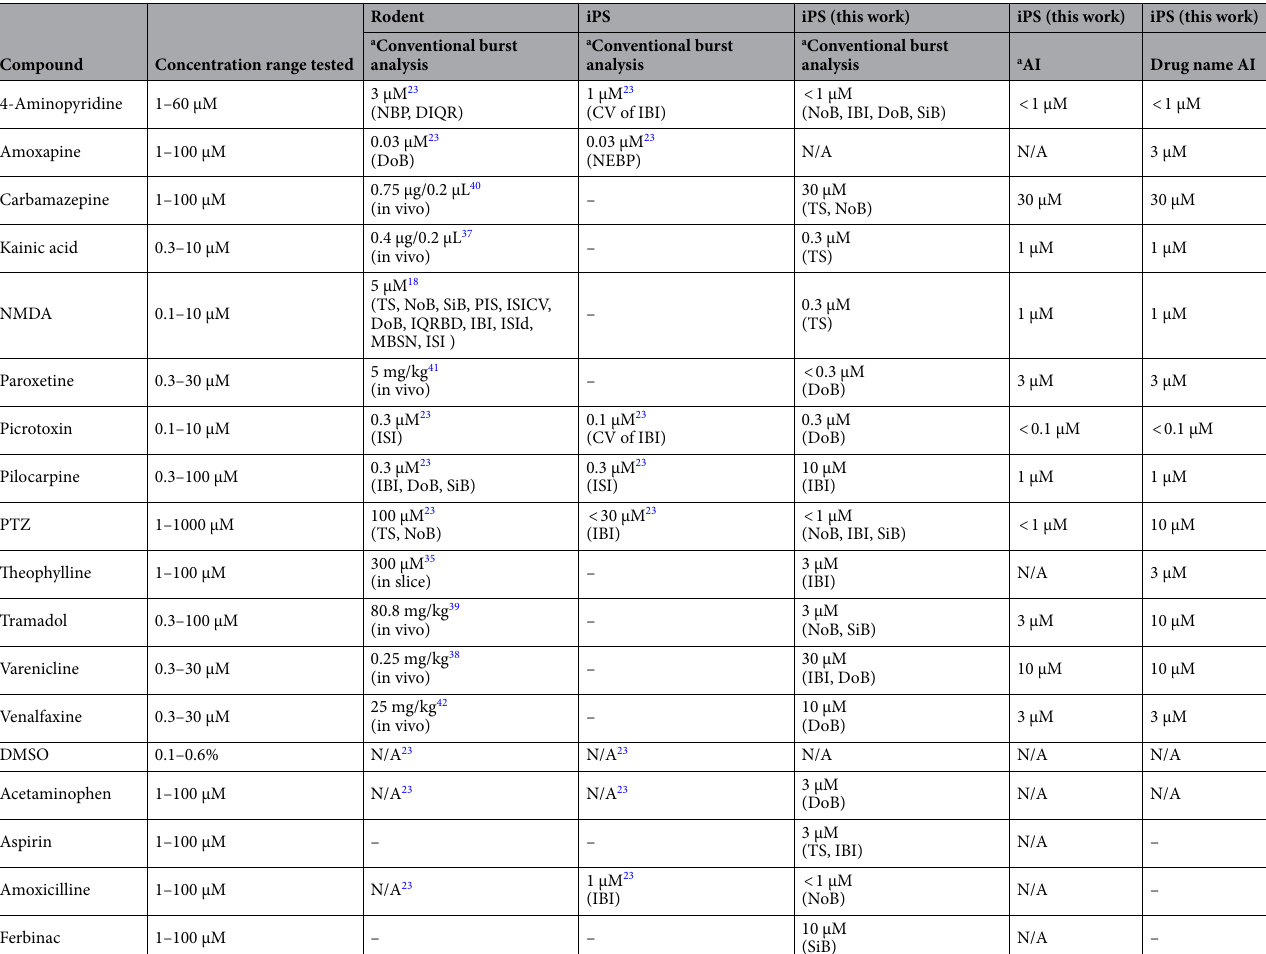
Table 5. Comparison with pre-clinical seizure assay benchmark using 15 compounds. NEBP no. of elecs. participating in burst, PIS percent isolated spikes, ISI inter spike intervals, ISI CV coefficient of variation